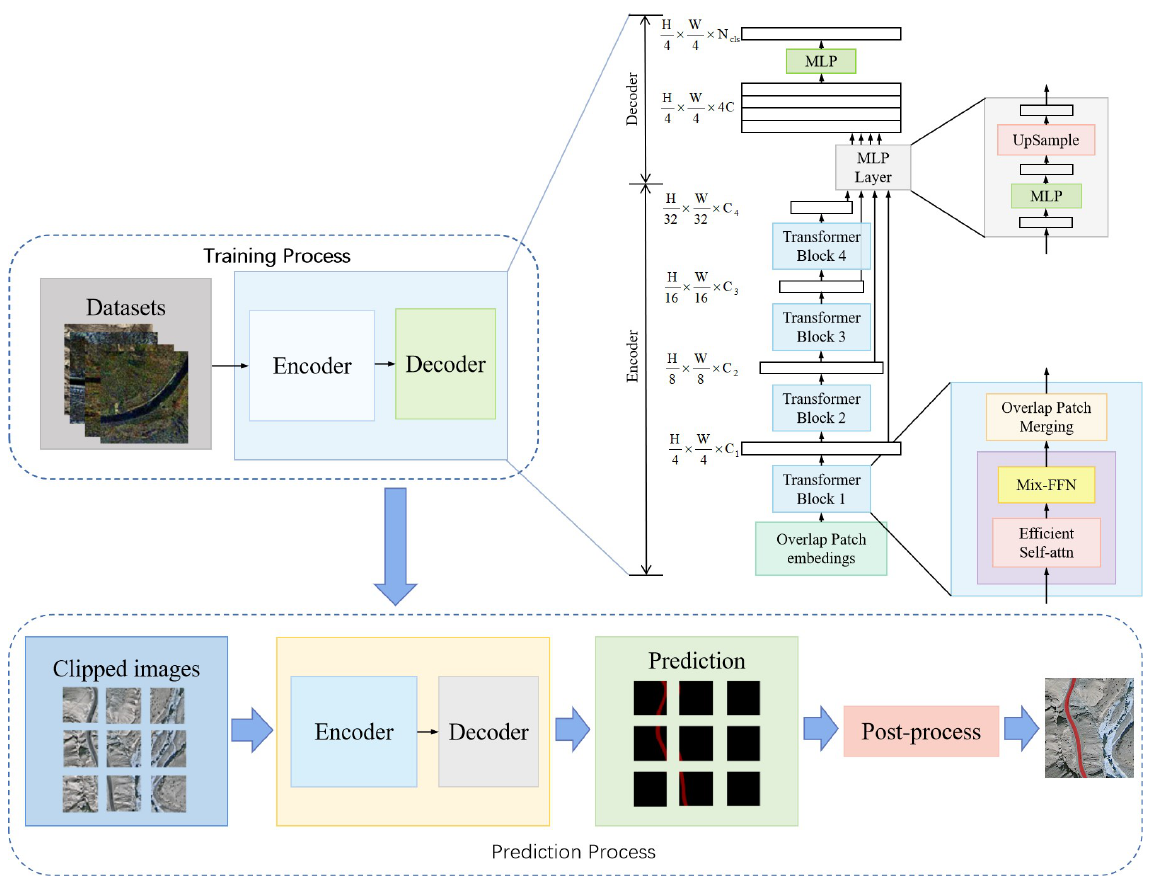
Figure 5. The Light Roadformer model consists of two parts, training and prediction, where both the training and prediction parts contain an encoding and decoding process. In the prediction module, we added post-processing steps to achieve more accurate prediction results.